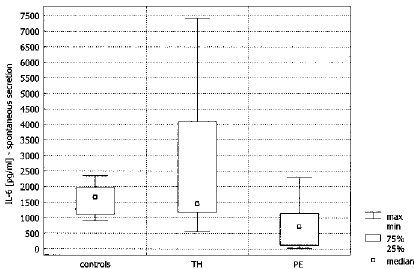
FIG. 5. Comparison of IL-12 spontaneous secretion in healthy pregnant women (controls) ( n = 11), and pregnant women with transient hypertension (TH) ( n = 17) and pre-eclampsia (PE) ( n = 21). The differences between all groups studied are not statistically significant